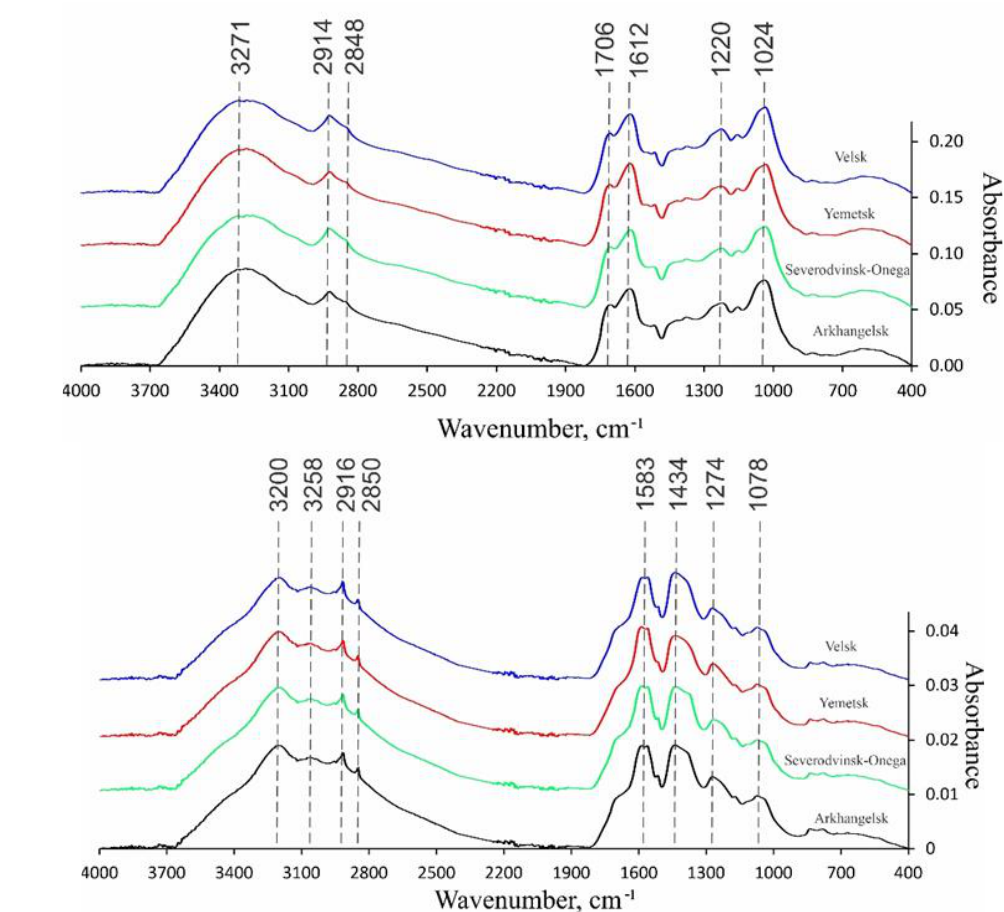
Figure 4. IR spectra of (a) the humic acids (HA) samples and (b) the fulvic acids